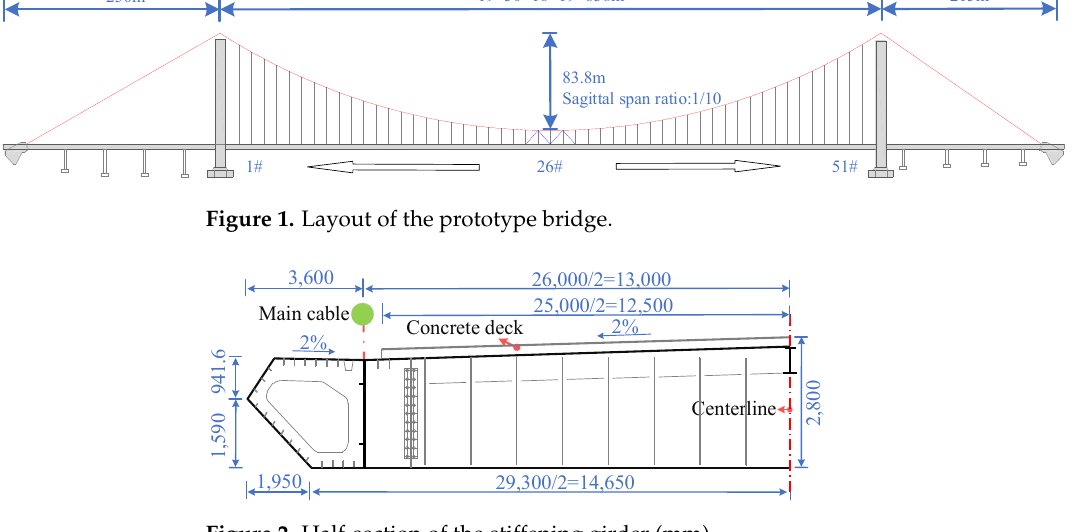
Figure 2. Half-section of the stiffening girder (mm).